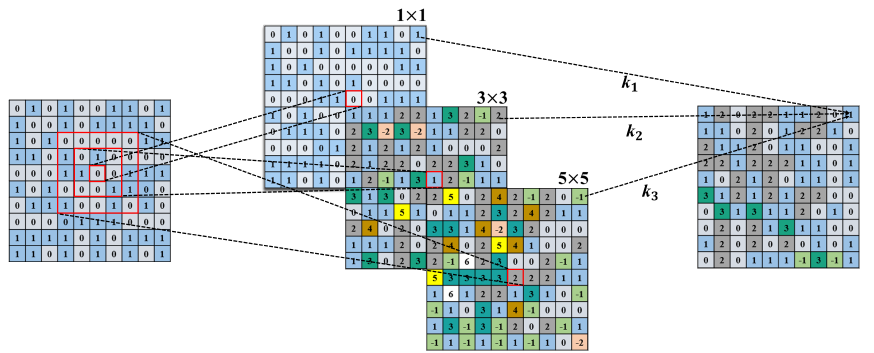
Figure 6. Multi-scale convolution